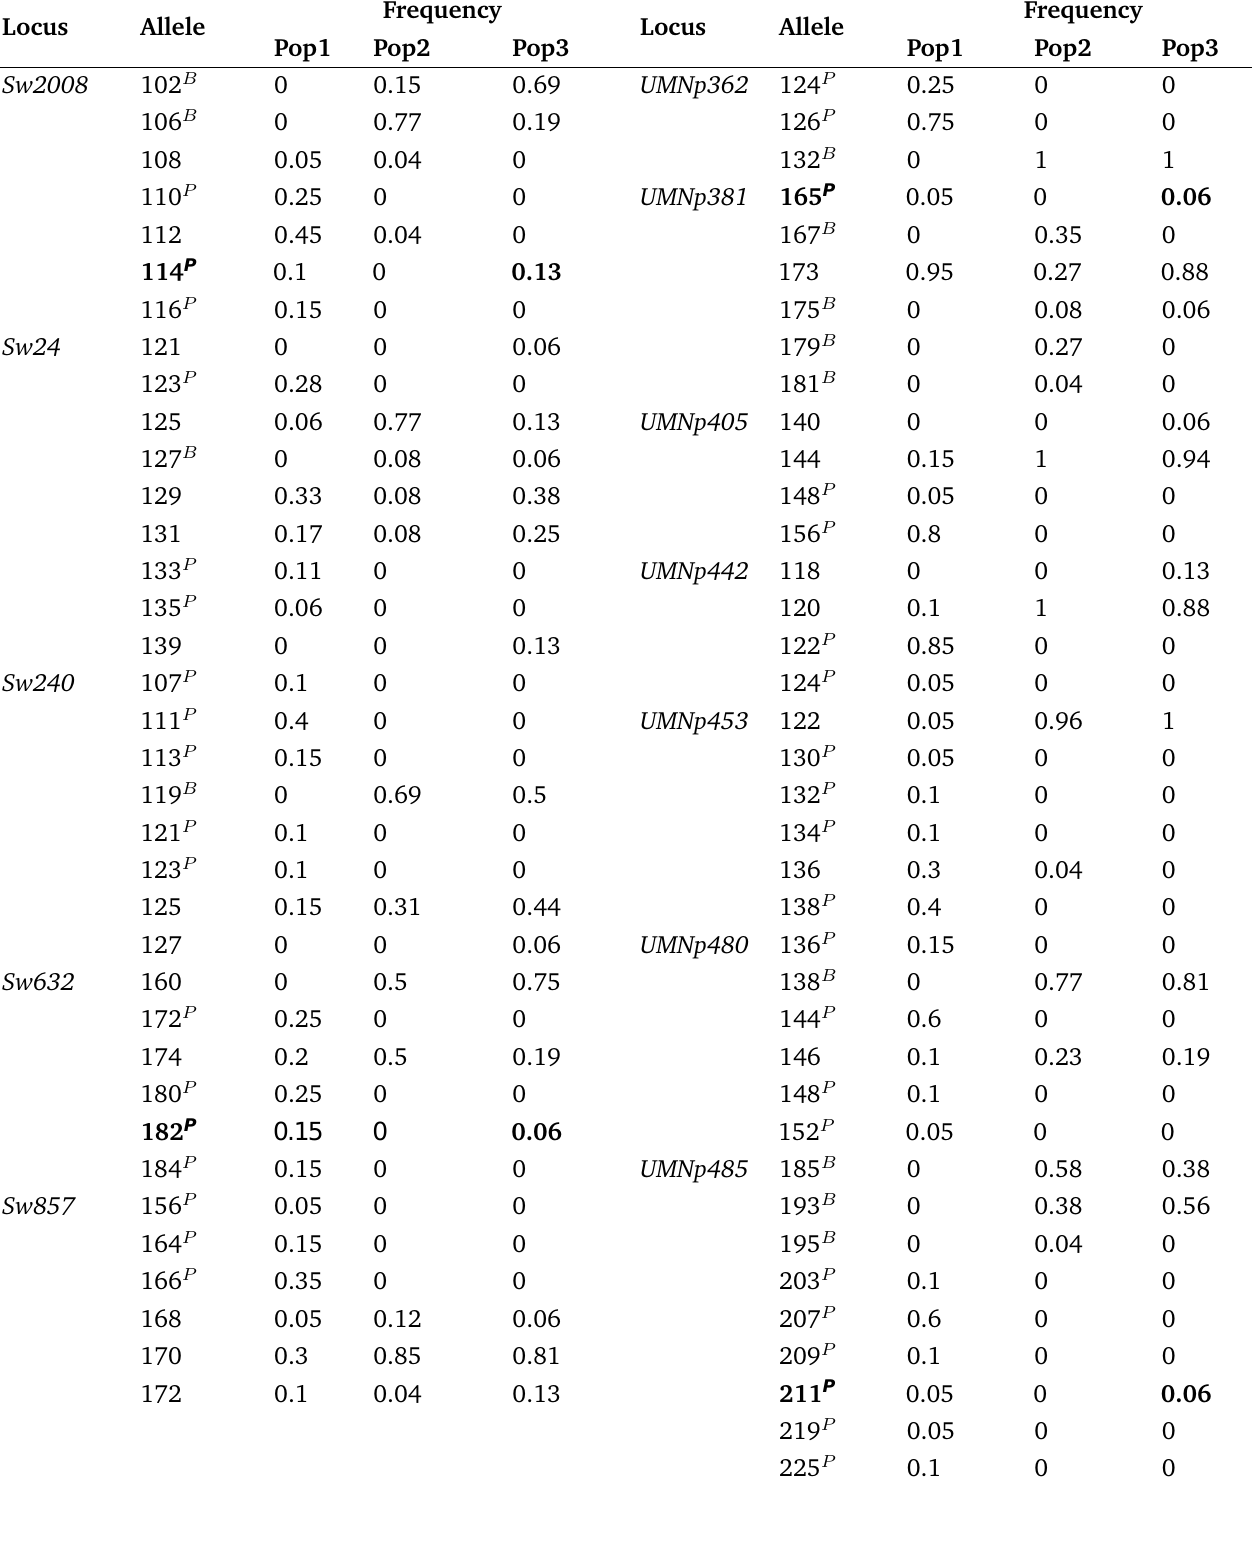
Table 4. Allele frequencies for selected microsatellite markers. Pop1 n=10; Pop2 n=13; Pop3 n=8. Allele P indicates putative pig alleles. Allele B indicates putative wild boar alleles. Bolded alleles indicate pig alleles putatively introgressed into the wild boar